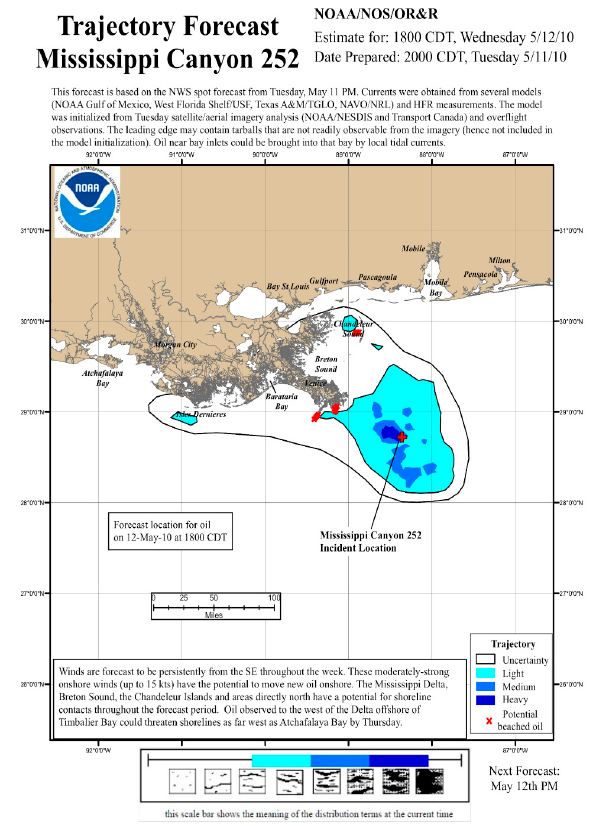
Figure 10. Example trajectory map produced by the National Oceanic and Atmospheric Administration (NOAA) for the Deepwater Horizon (DwH) spill. The blue contours indicate the model’s “best estimate” of the location of oil of different concentrations. The line surrounding the larger region is the “uncertainty bound”, indicating a larger area where oil might be found, reflecting the uncertainty in the inputs.